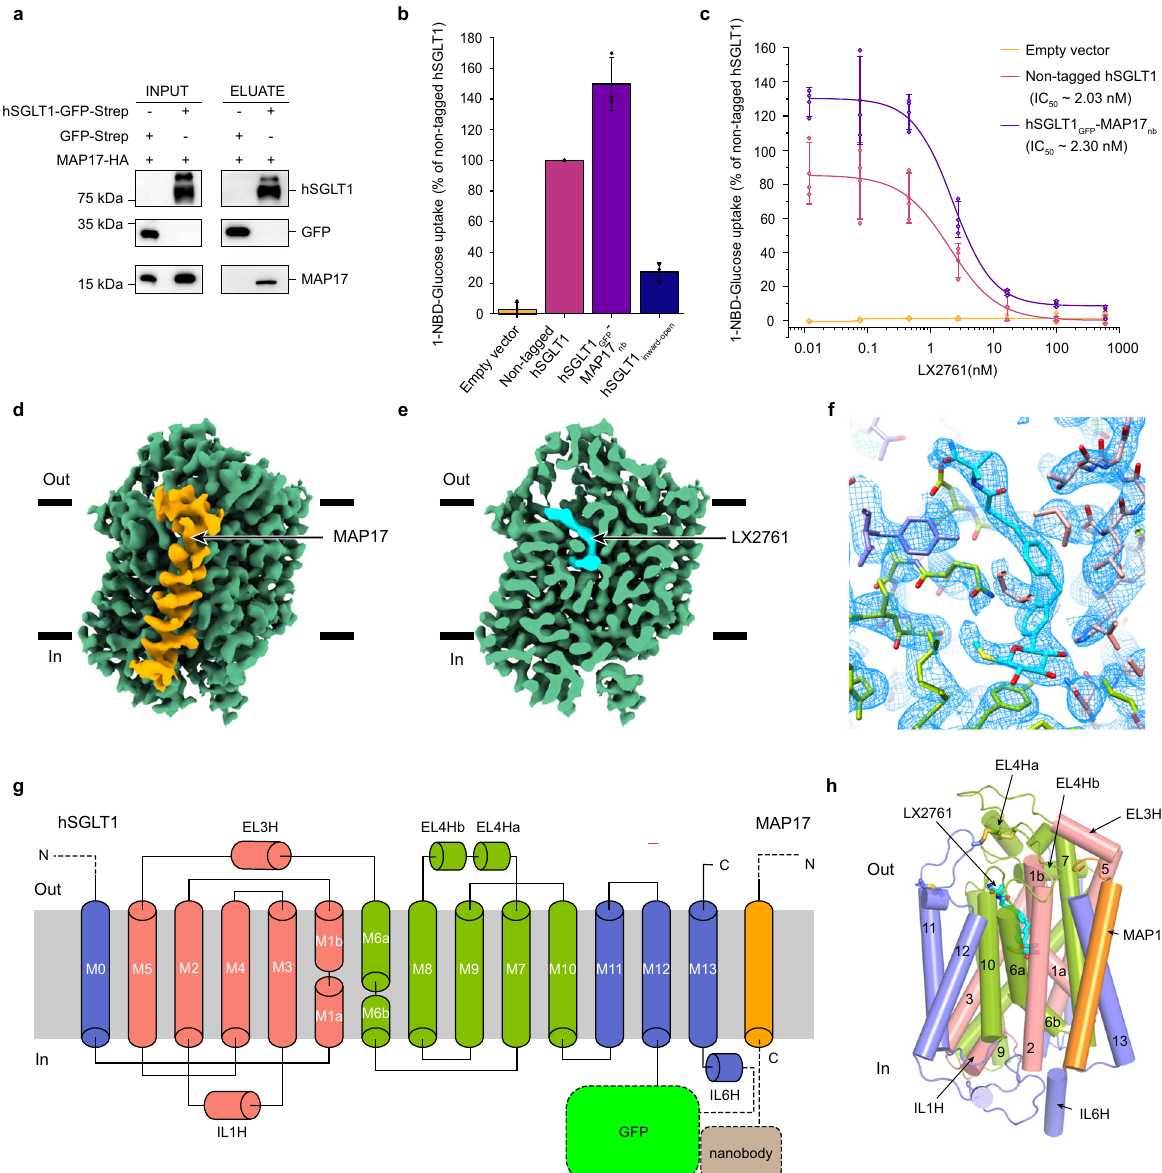
Fig. 1 | Cryo-EM structure of human SGLT1-MAP17 complex. a Immunoblot analysis for hSGLT1 and MAP17 in strep af fi nity precipitates (The experiment have been repeated with three times with similar results). b The 1-NBD-glucose uptake activities of non-tagged hSGLT1, hSGLT1 GFP -MAP17 nb , and hSGLT1 inward-open con- structs (data are shown as means±standard deviations; n = 3 biologically indepen- dent experiments). c The inhibition of non-tagged hSGLT1 and hSGLT1 GFP -MAP17 nb